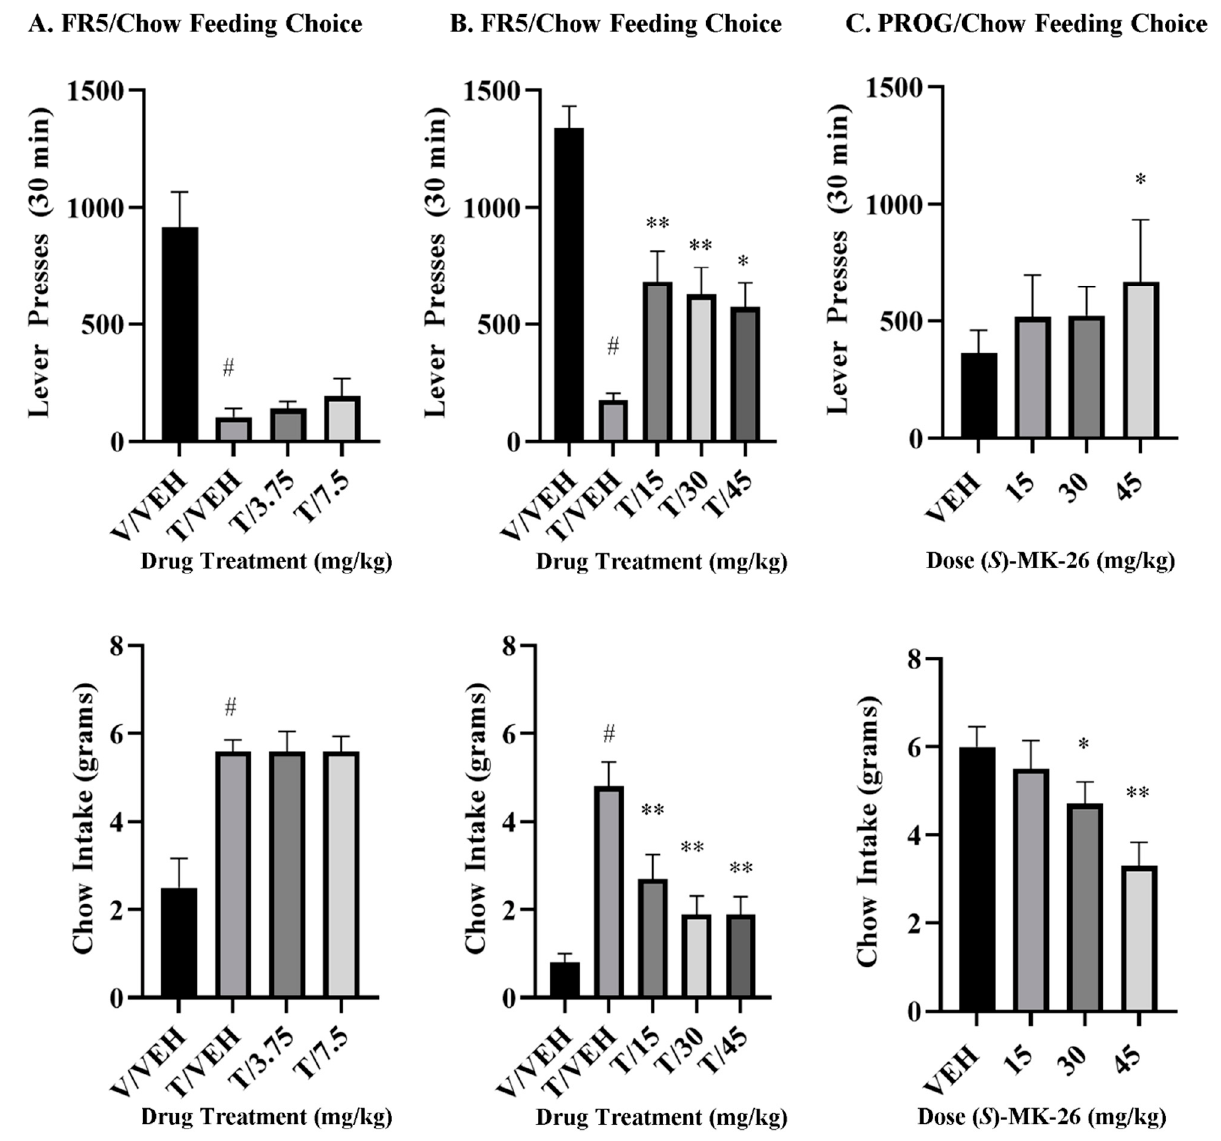
Figure 9. The effects of ( S )-MK-26 on effort-based choice using the FR5/chow and PROG/chow feeding choice task. For FR5/chow procedure, rats ( n = 8) received i.p. injections of vehicle plus vehicle (V/VEH), 1.0 mg/kg TBZ plus vehicle (T/VEH), or TBZ plus 3.75, 7.5 mg/kg for the low-dose progression ( A ), and 15.0, 30.0, or 45.0 mg/kg for the high-dose progression ( B ) of ( S )-MK-26. For PROG/chow procedure, rats ( n = 15) received i.p. injections of vehicle (VEH), 15.0, 30.0, or 45.0 mg/kg doses of ( S )-MK-26 ( C ). Top: Mean (± SEM) number of lever presses during the 30 min session. TBZ plus vehicle significantly differed from vehicle plus vehicle (# p < 0.001); TBZ plus 15.0 and 30.0 mg/kg of ( S )-MK-26 (** p < 0.01); and TBZ plus 45.0 mg/kg of ( S )-MK-26 (* p < 0.05). For PROG/chow schedule, 45.0 mg/kg ( S )-MK-26 significantly differed from vehicle (* p < 0.05). Bottom: Mean (± SEM) gram quantity of chow intake. TBZ plus vehicle significantly differed from vehicle plus vehicle (# p < 0.001); TBZ plus 15.0, 30.0 and 45.0 mg/kg of ( S )-MK-26 (** p < 0.01). For PROG/chow schedule, 30.0 and 45.0 mg/kg of ( S )-MK-26 significantly differed from vehicle (* p < 0.05 and * p < 0.01, respectively).